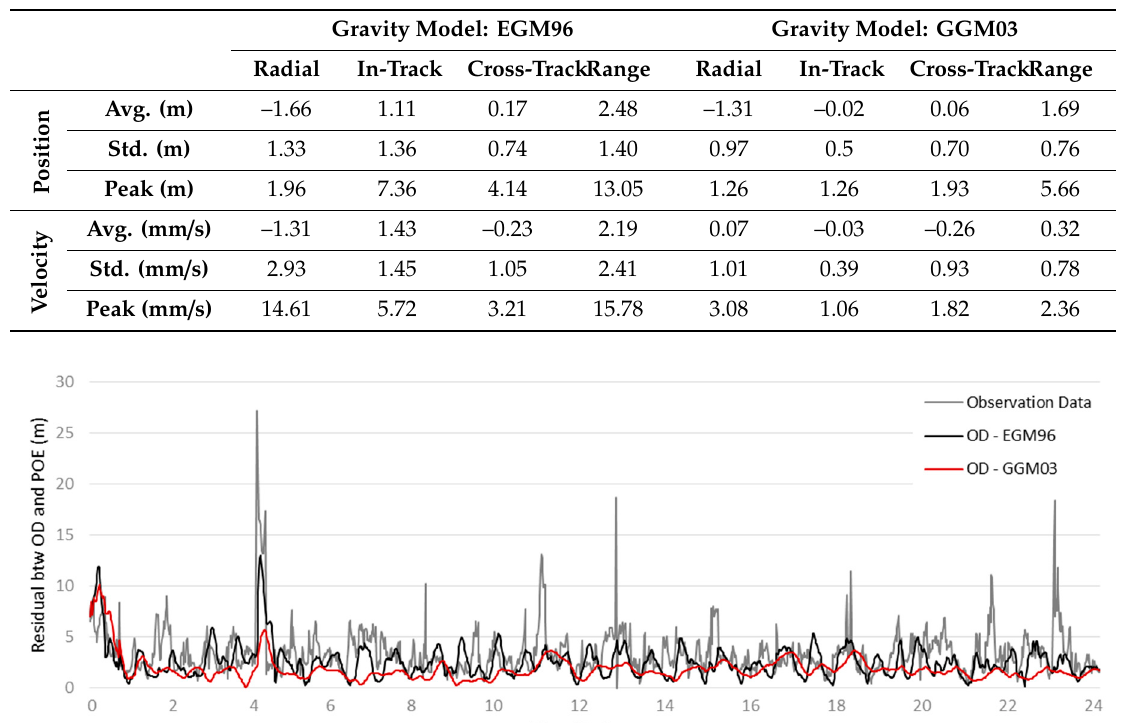
Table 4. Performance analysis results of on-board orbit determination with respect to the reference orbit from CHAMP POE.